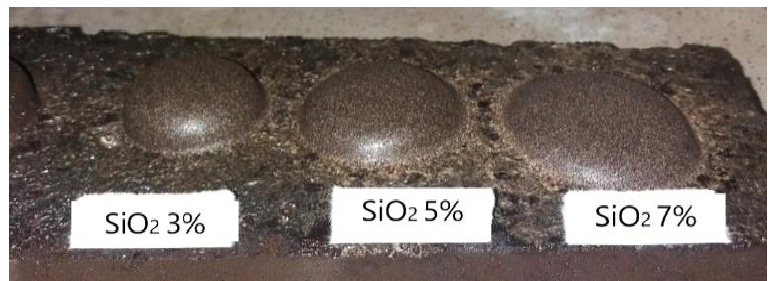
Figure 6. Peridotite sample E6382 with the SiO 2 addition after calcination.